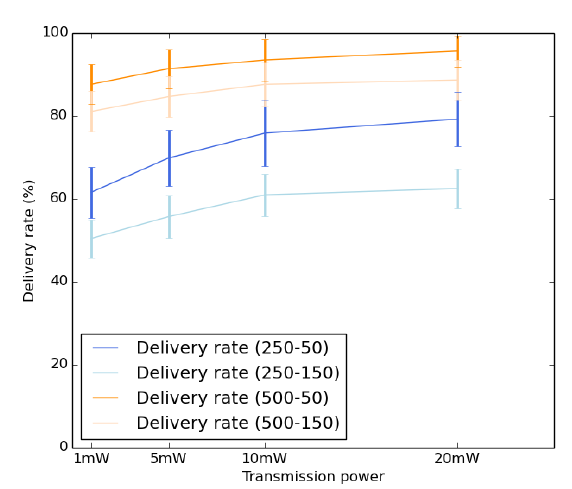
Figure 14. Average delivery rate.